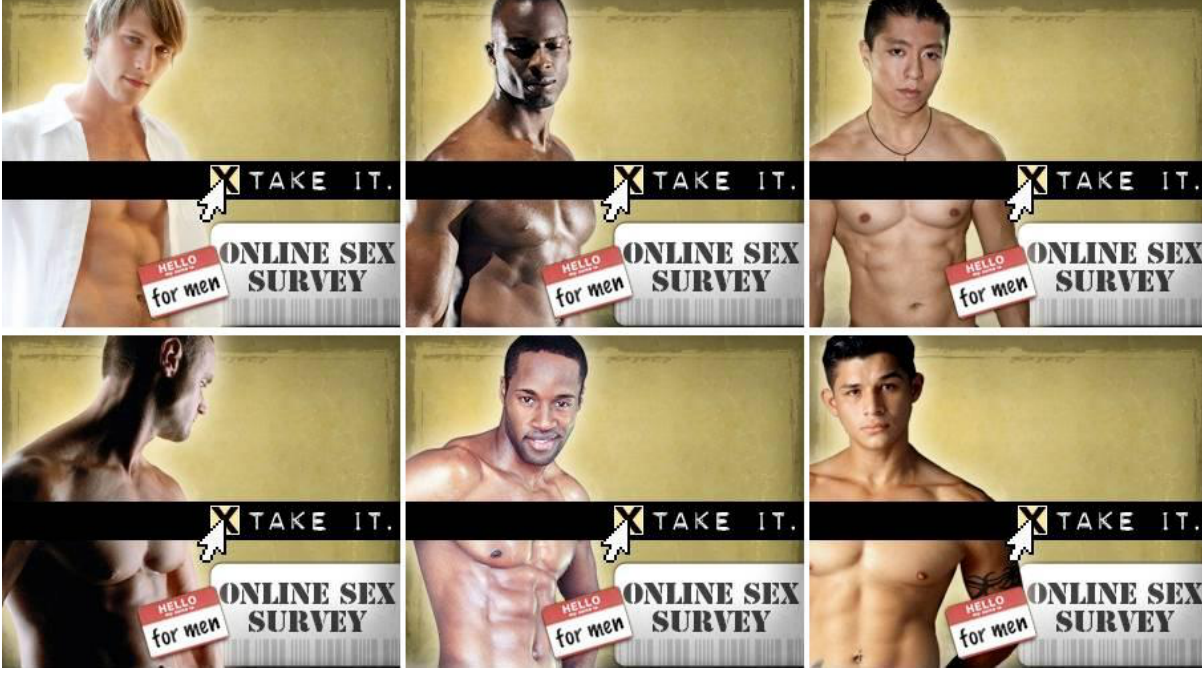
Participants referred to the survey site after clicking through the banner advertisement were first screened for